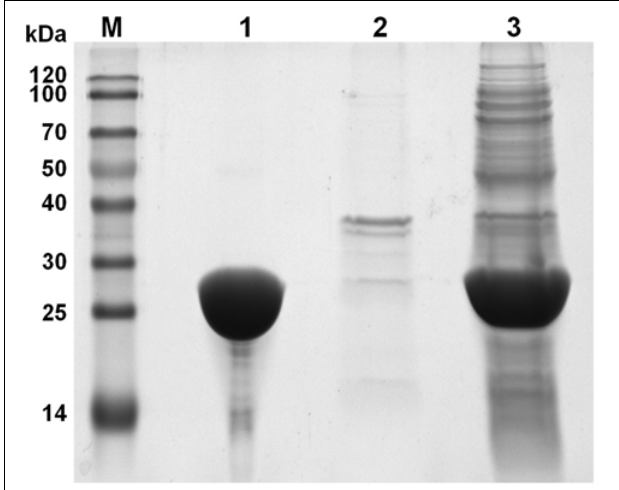
FIGURE 4 | SDS-PAGE spectrum of Aa SOD. Lane M, Marker; lane 1, purified protein after His-Trap affinity column; lane 2, cell debris of the E. coli recombinant harboring Aa SOD; lane 3, supernatant of the E. coli recombinant harboring Aa SOD induced by IPTG for 12 h at 18 ◦ C.